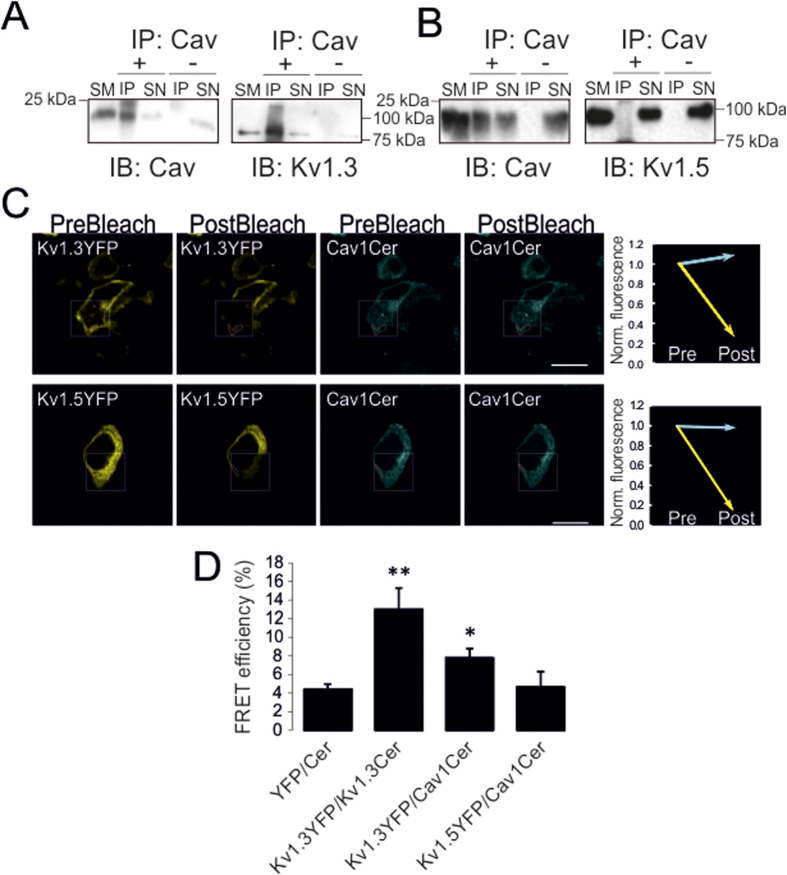
Molecular association of Kv1.3 with caveolin.HEK Cav1 cells were transfected with Kv1.3 (A) and Kv1.5 (B) and, after lipid raft isolation, floating fractions were subjected to caveolin immunoprecipitation (IP: Cav) in the presence (+) and the absence (−) of caveolin antibody. Blots were analyzed for the presence of Kv1.3 (IB: Kv1.3), Kv1.5 (IB: Kv1.5) and Cav1 (IB: Cav). SM: starting material; SN: Supernatant; IP: immunoprecipitate. (C) Representative FRET images of HEK Cav- cotranfected with Cav1-Cerulean and Kv1.3YFP (top panels) or Kv1.5YFP (bottom panels). Images from left to right show acceptor (Channel-YFP) prebleach and postbleach and donor (Cav1-Cerulean) prebleach and postbleach images. Squares insets indicate the bleached zone containing the quantified red limited areas. The line graphs at the right show changes in donor (cyan) and acceptor (yellow) fluorescence after bleach (D) Histogram with the FRETeff quantification (%) of YFP-Cer (negative control), Kv1.3YFP-Kv1.3Cer (positive control), and samples from (C). Data are the mean ± SE (n > 35). *p < 0.05; **p < 0,01 vs YFP-Cer (Student’s t-test).